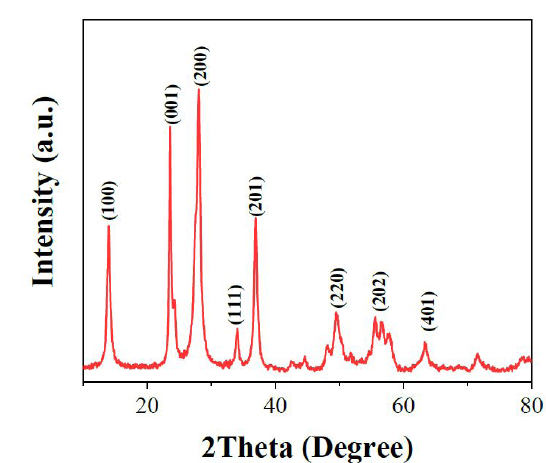
Figure 2. Schematic diagram of the WS-30A gas-sensing measurement system.